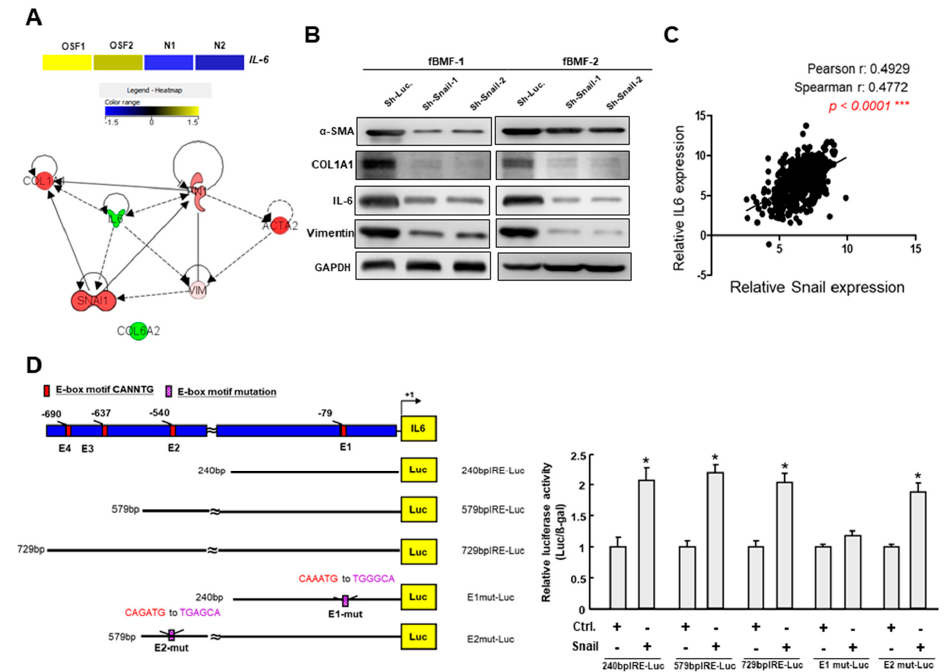
Figure 5. Snail directly binds to the IL-6 promoter via its E-box. ( A ) RNA sequencing analysis showed that IL-6 was upregulated in OSF tissues compared to the normal buccal mucosa (upper panel); Predicted interacting factors of Snail using bioinformatics software (lower panel); ( B ) Protein expression of several fibrosis factors, including α -SMA, type I collagen, IL-6 and vimentin, in fBMFs transduced with sh-Luc or sh-Snail; ( C ) Analysis of the relationship between Snail and IL-6 using OSCC data from The Cancer Genome Atlas (TCGA); ( D ) Schematic representation of E-box domain in IL-6 promoter region and reporter constructs. The full-length, deletion and mutated promoter reporter constructs were designed and subjected to a luciferase-based reporter